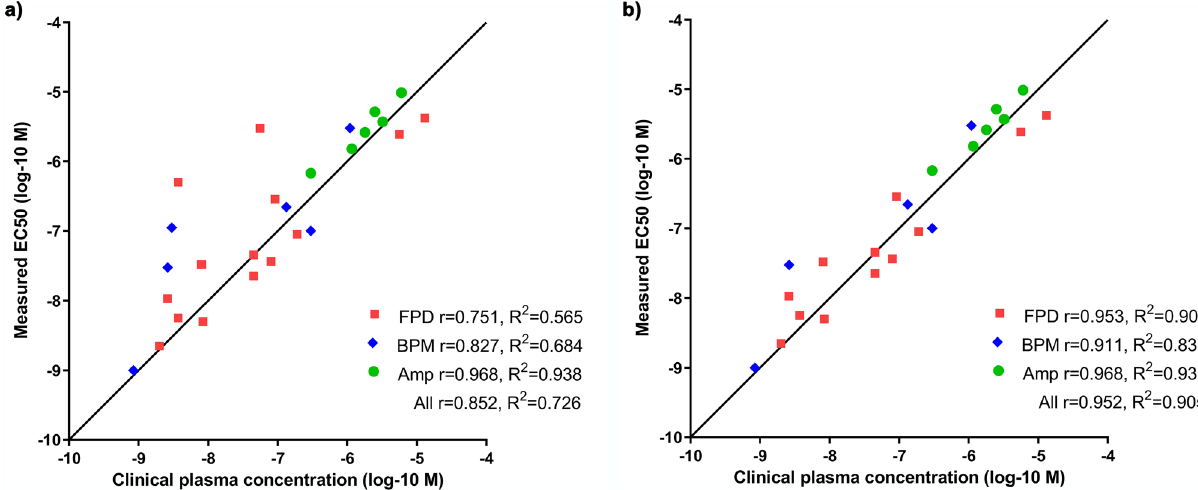
Figure 5. Cardiac tissue model yielded high predictivity in drug testing with high correlation to human data. Correlation between measured EC 50 values and clinical plasma concentrations of ( a ) 26 study compounds (drugs) and ( b ) without alfuzosin, digoxin and tolterodine. Correlation scores for the groups are calculated using Pearson r. Goodness of fit is expressed as R 2 . Number of replicates n = 4–8 per repeat depending on MEA well format, repeated three